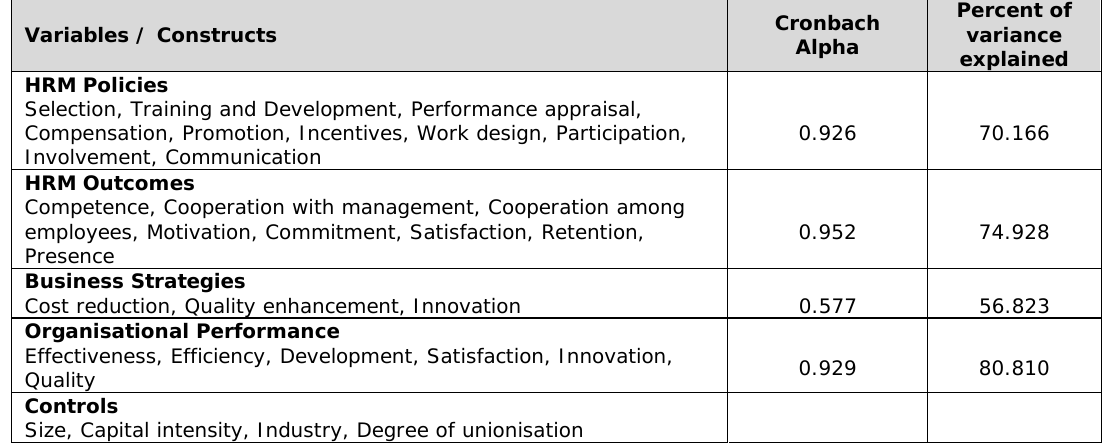
Table 2. “Variables of the survey